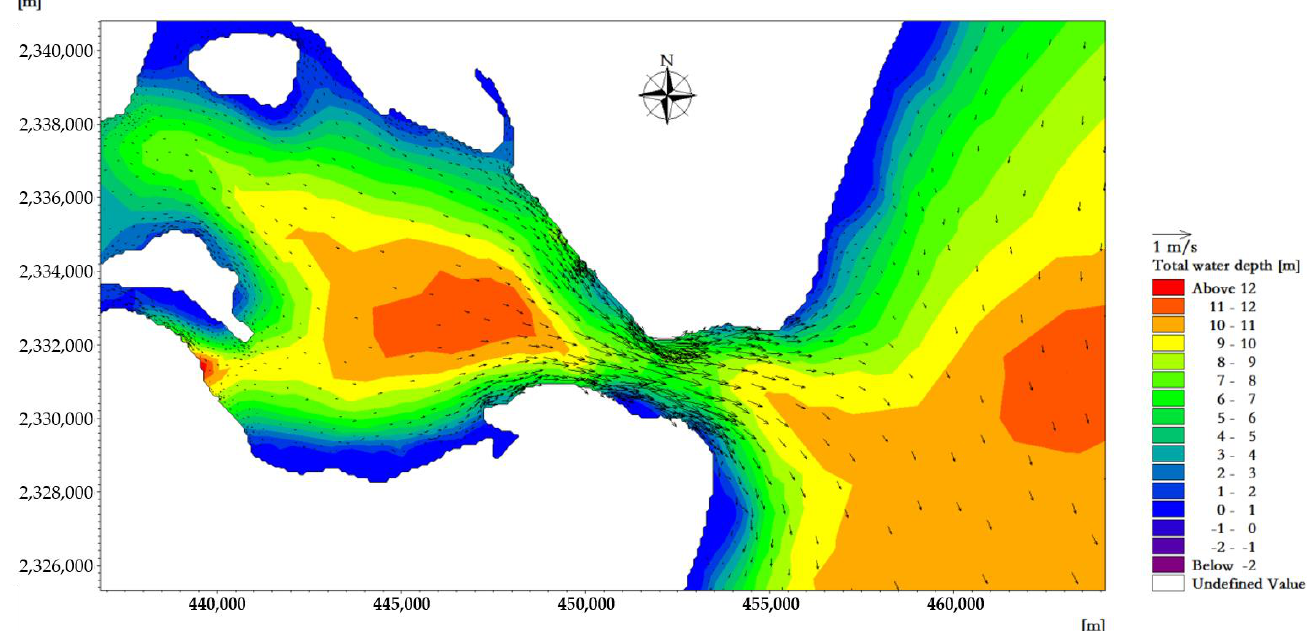
Figure 8. Flow field plane distribution near the tidal inlet at the moment when the velocity of the ebb tide reaches its maximum.